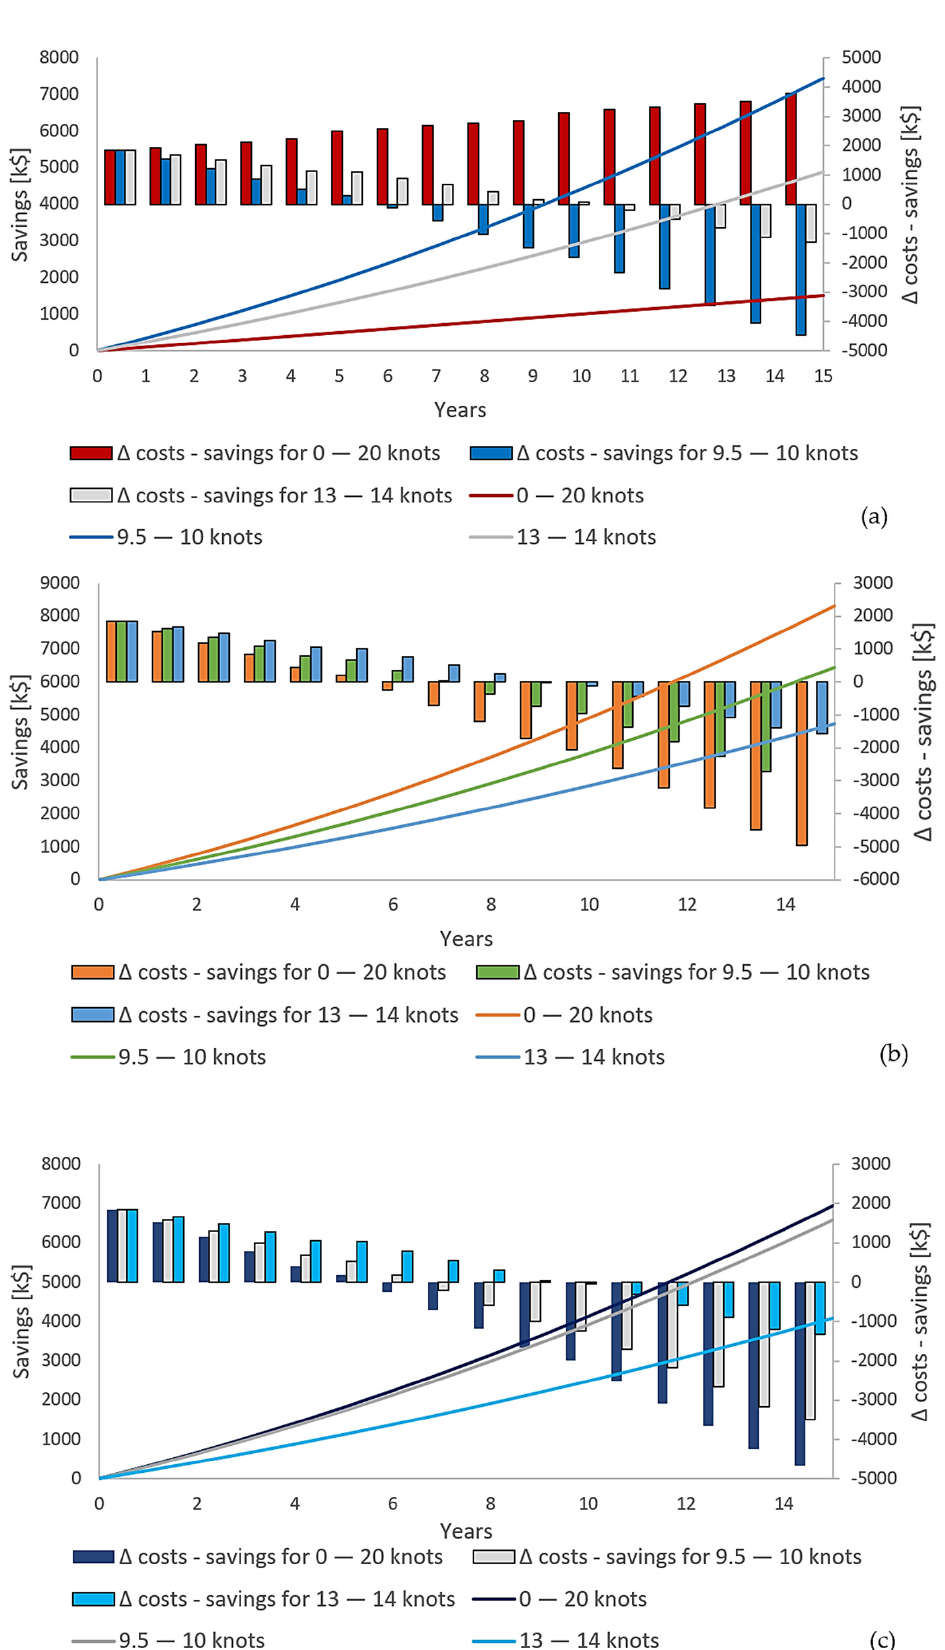
Figure 18. 6DOF simulation for a route from Singapore to San Francisco in different rotor configu- rations: ( a ) D = 5 m and AR = 6; ( b ) D = 3 m and AR = 8; ( c ) D = 3 m and AR = 6.